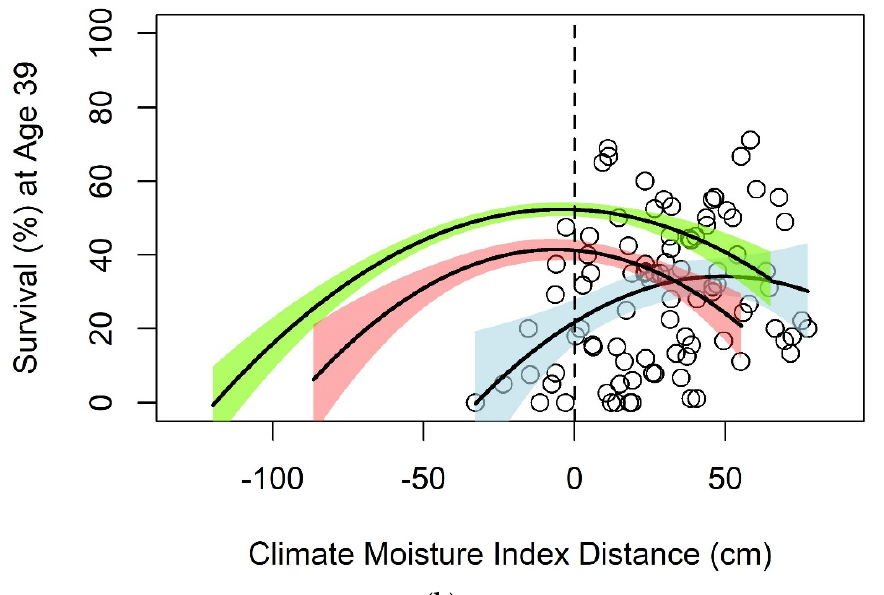
Figure 6. Relationship between climate moisture index transfer distance and ( a ) height and ( b ) survival of jack pine seed sources at 39 years of age. Separate regression lines and 95% confidence intervals are shown for southern (red), central (green), and northern (blue) seed sources. Data points (black circles) are shown only for northern seed sources. The vertical dashed line indicates local deployment of seed sources (i.e., a transfer distance of zero); points to the right of this line indicate seed transfers to wetter planting sites and vice versa.